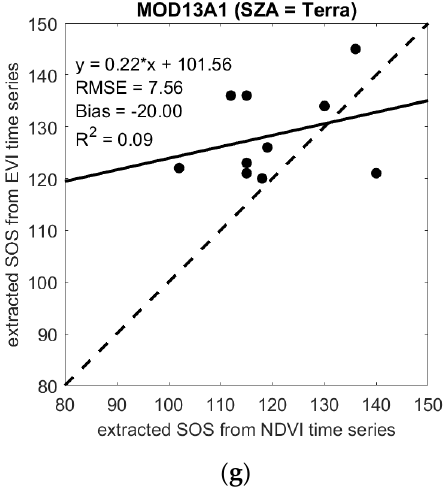
Figure 5. Comparison of SOS derived from the NDVI and EVI time series from 2001 to 2010 when the SZA is ( a ) 0°; ( b ) 15°; ( c ) 30°; ( d ) 45°; ( e ) 60°; ( f ) at local solar noon; and ( g ) dependent on the observations of the Terra satellite. ( a – e ) are derived from the simulations, while ( f , g ) are from the MCD43A4 (NBAR) product and MOD13A1 (VI) product, respectively.